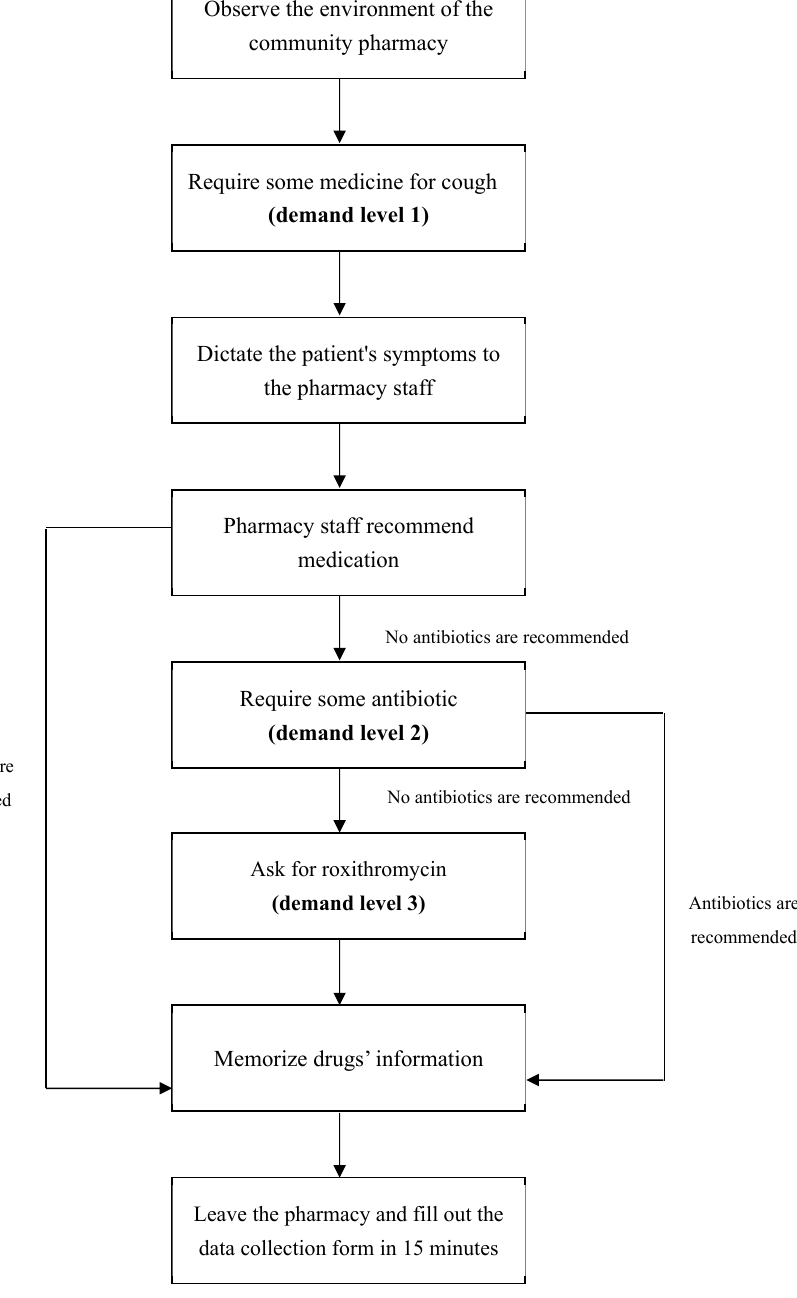
Figure A1. Visit procedure. The specific operation of the procedure is as follows: